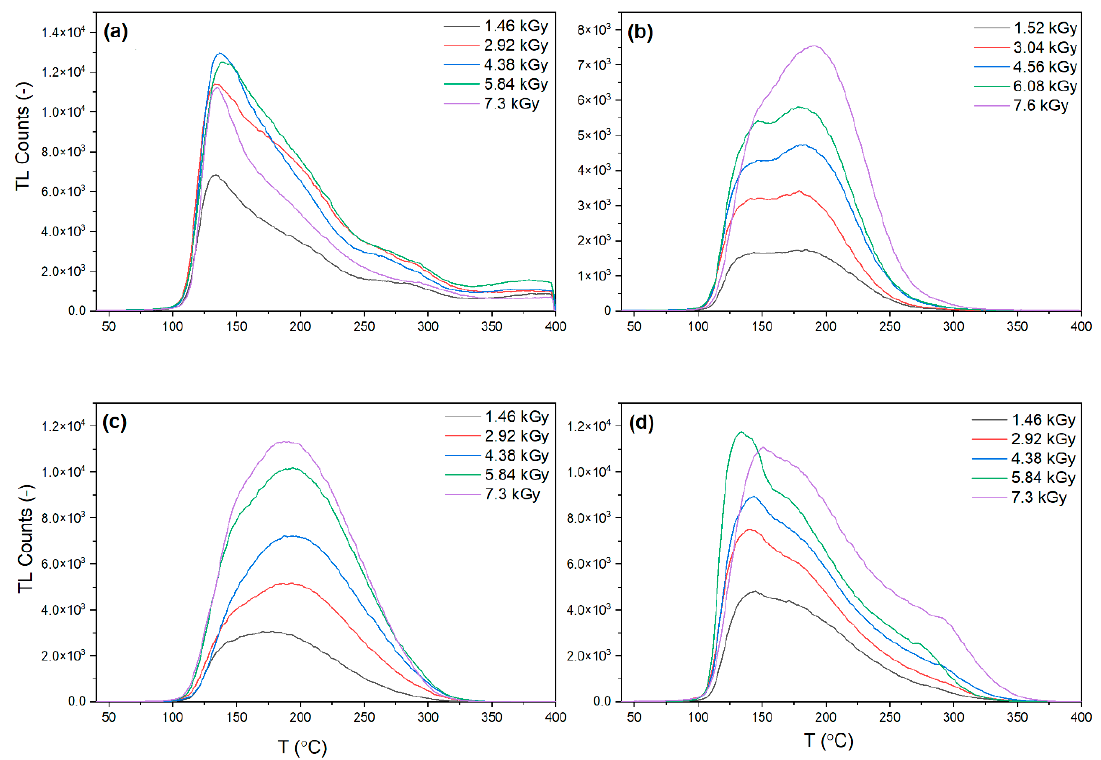
Figure 6. TL curves for samples irradiated using gamma radiation (irradiation chamber), PPG ( a ), PPG_Tb01 ( b ), PPG_Tb05 ( c ), and PPG_Tb30 ( d ); PPG samples read without shutter.